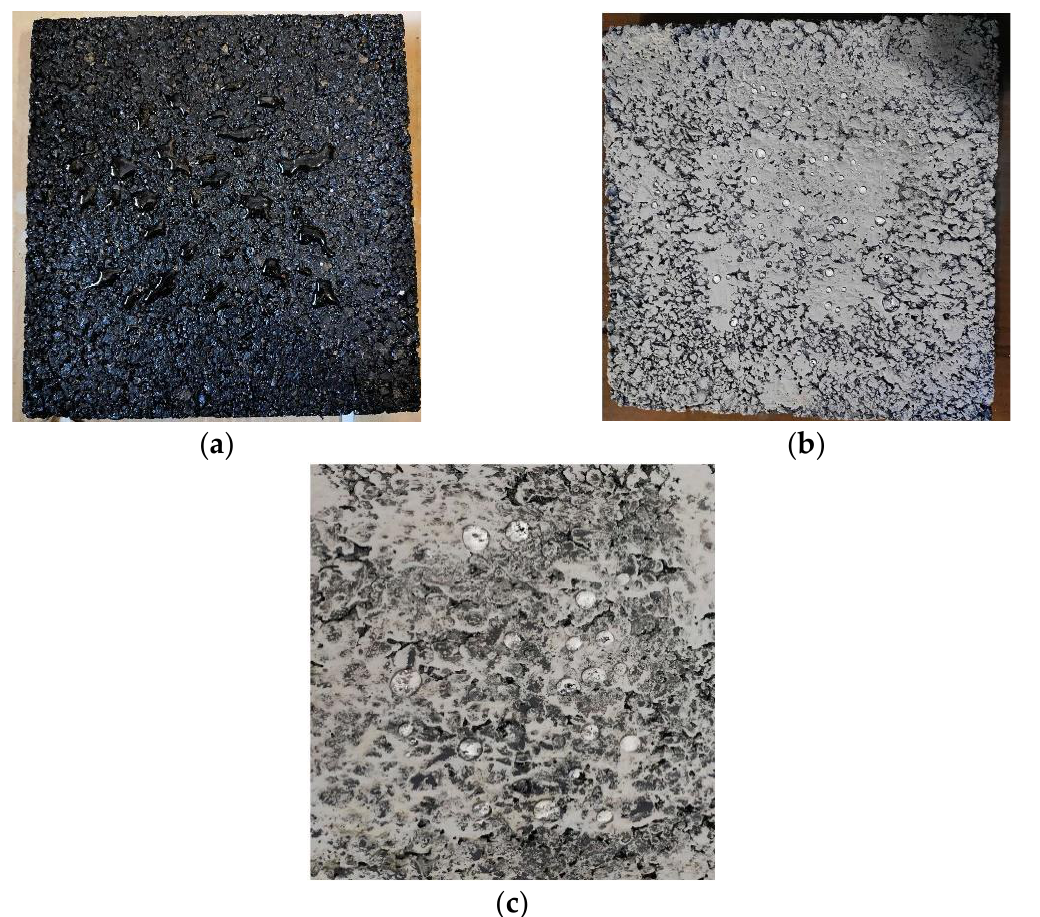
Figure 11. Sample water contact state before and after abrasion: ( a ) Water contact state of untreated sample surface; ( b ) water contact state of PSC treated sample surface; ( c ) the water contact state of the sample surface at the abrasion position.